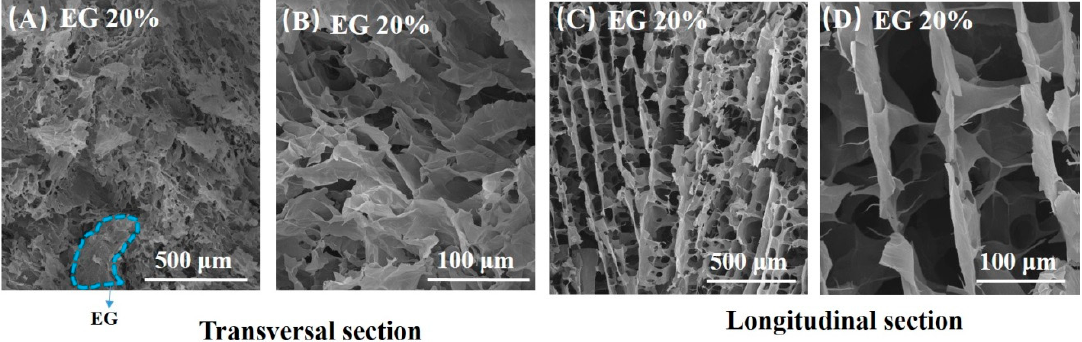
Figure 2. SEM photos of transversal section of rGO/EG aerogel with EG content of 20%( A – B ), SEM photos of longitudinal section rGO/EG aerogel with EG content of 20%( C – D ).